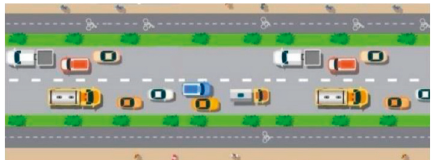
Figure 3: Vehicular ad hoc networking for linear routes in in- telligent